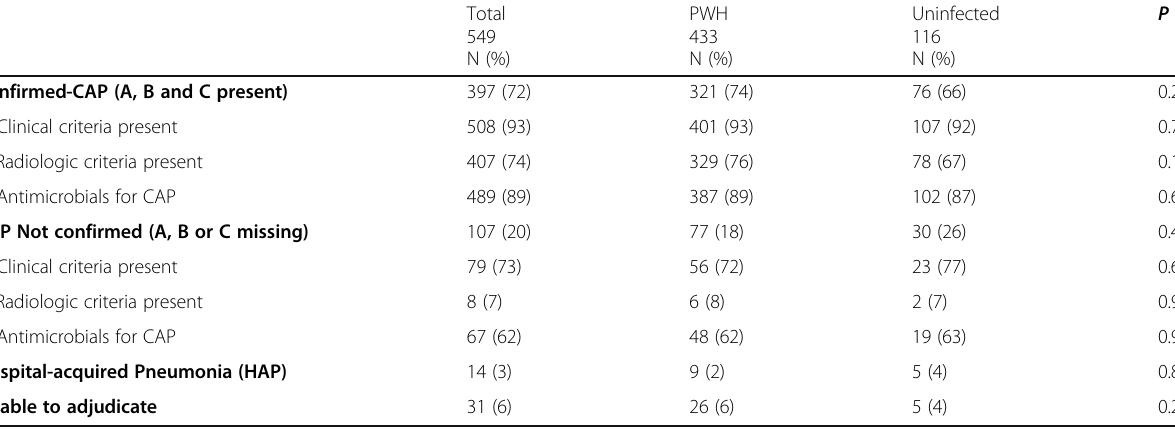
A-Clinical, symptoms, signs and/or laboratory finding compatible with CAP B-Radiologic, chest radiograph and/or CT chest compatible with CAP C-Antimicrobials for CAP, antimicrobials administered within 48h of